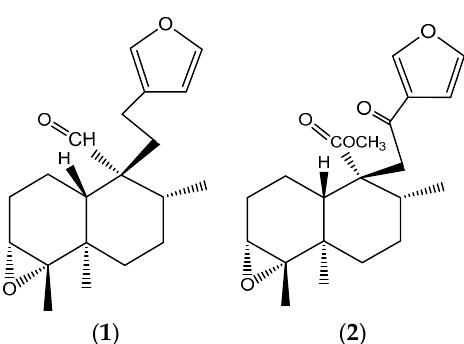
Figure 1. Clerodane-type diterpenoids identified in the dichloromethane fraction of EC: hypolein B ( 1 ) and Crotonpene B ( 2 ).